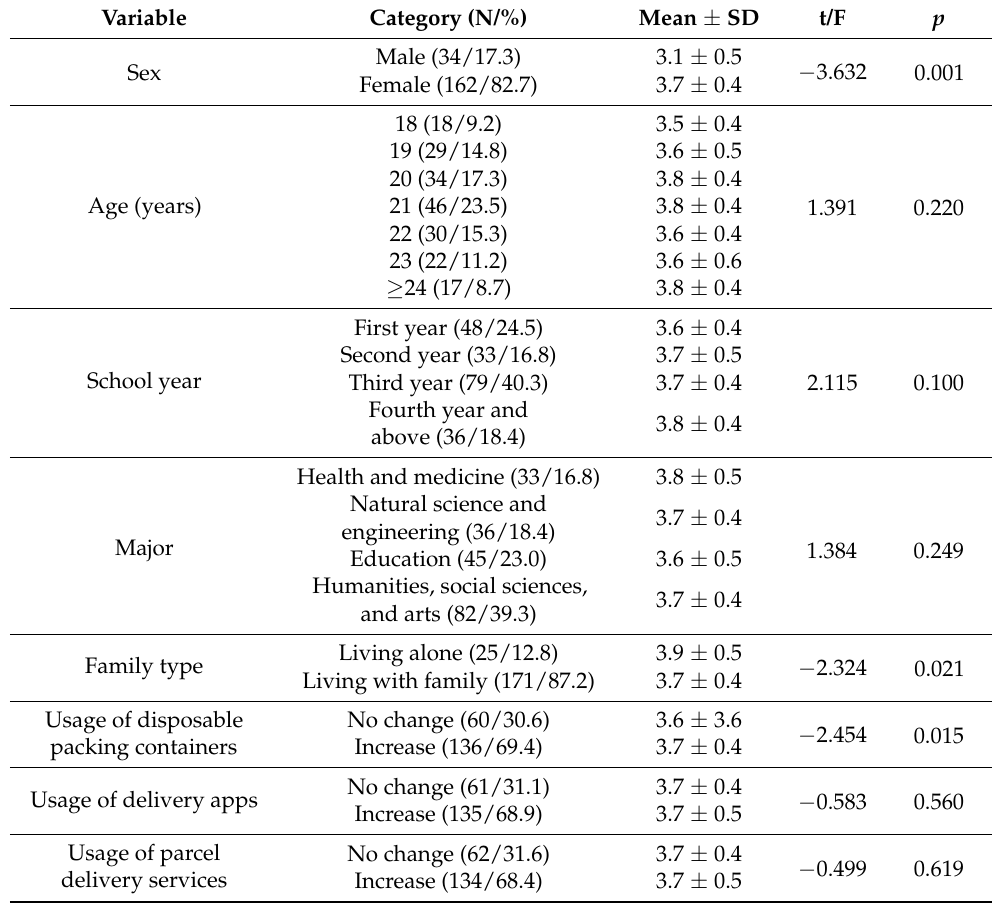
Table 1. General characteristics and differences in zero-waste behaviours depending on the usage change in disposables during COVID-19 (n =